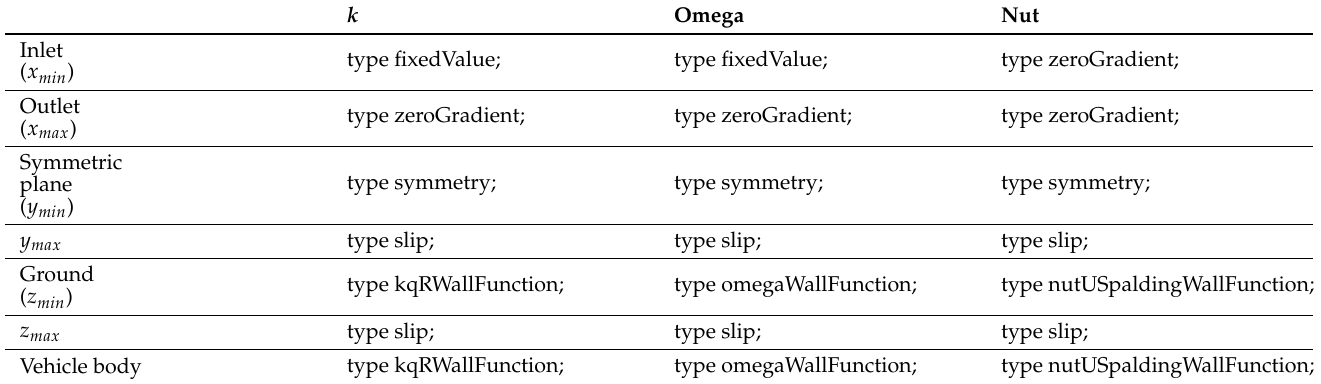
Table 2. Summary of the boundary conditions of the CFD simulation. (k,